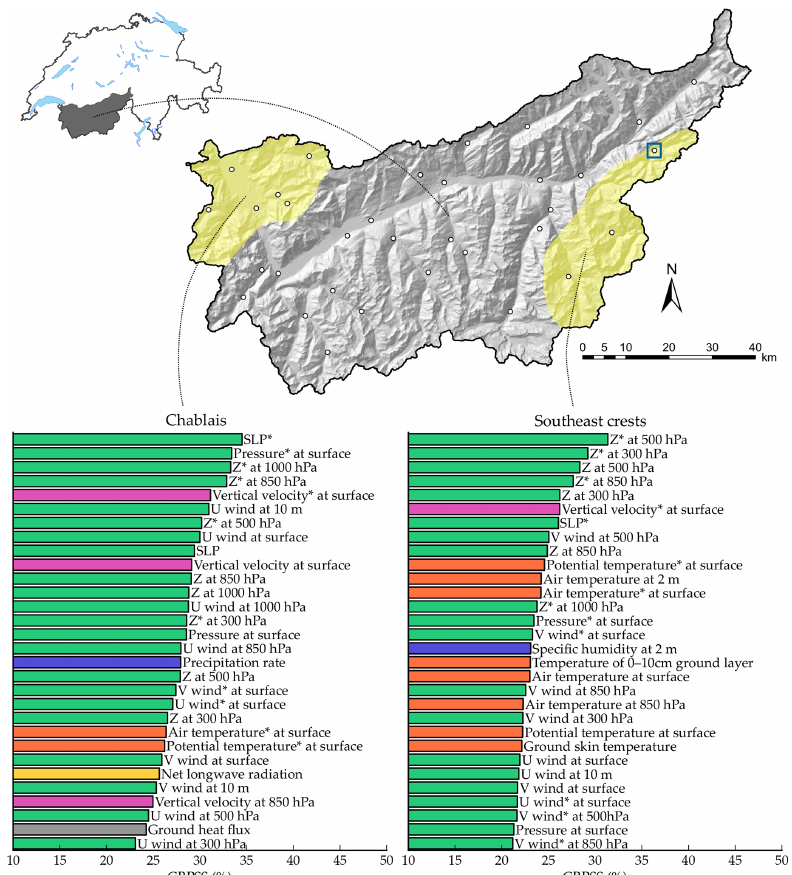
Figure 1. Performance score (CRPSS; Eq. 3; the reference being the climatological precipitation distribution) of the 30 best variables from the NR-1 dataset, when considered separately (no combination), for the Chablais region and the southeast ridges in the upper Rhône catchment in Switzerland. The analogy criterion is S1 when an asterisk is present next to the variable name and RMSE otherwise. Color illustrates the variable type. Green: atmospheric circulation, blue: moisture, orange: temperature, yellow: radiation, purple: vertical velocity, and gray: other. SLP stands for sea level pressure and Z for geopotential height. The blue square indicates the Binn station.